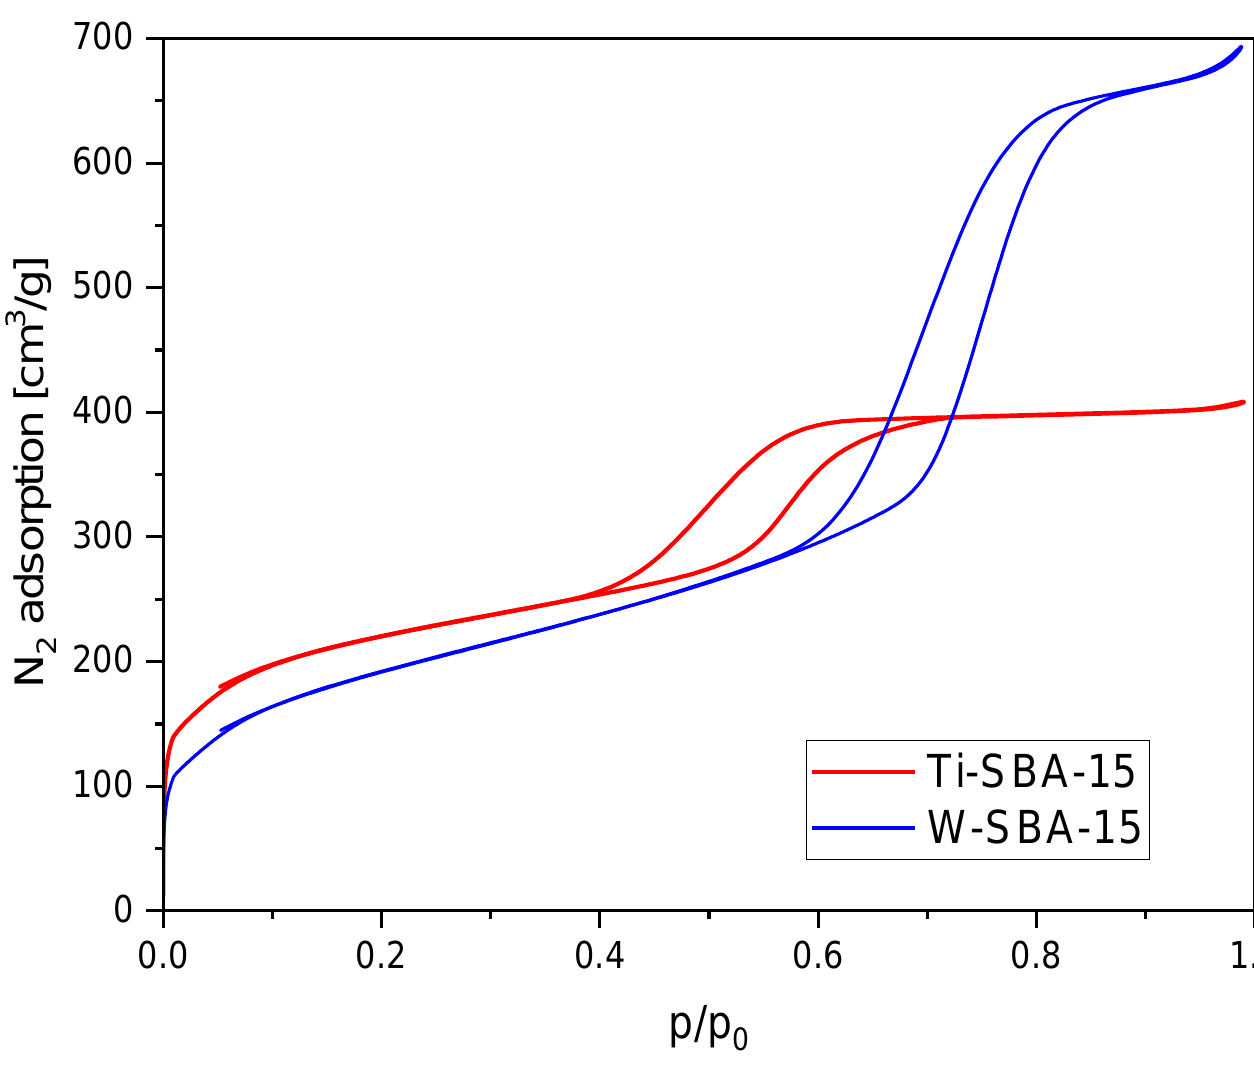
Figure 2. Nitrogen sorption isotherms of Ti-SBA-15 and W-SBA-15.